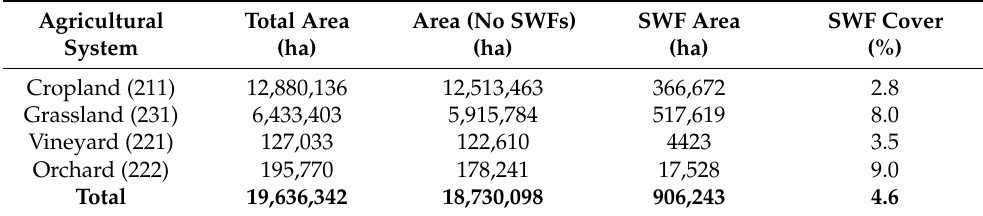
Table 2. Total area (ha), agricultural area without SWF (small woody landscape feature) cover (ha), SWF area (ha), and proportion of SWF cover (%) of four agricultural systems across Germany (including CORINE codes).